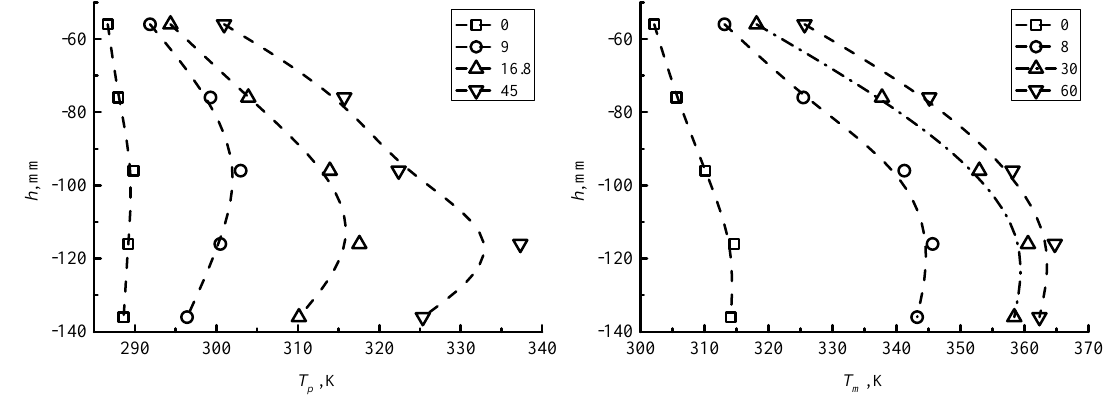
Figure 9. Temperature distribution along casting direction of mould wall at t = 22 s for different P for trial A ( left ) and trial B ( right ),